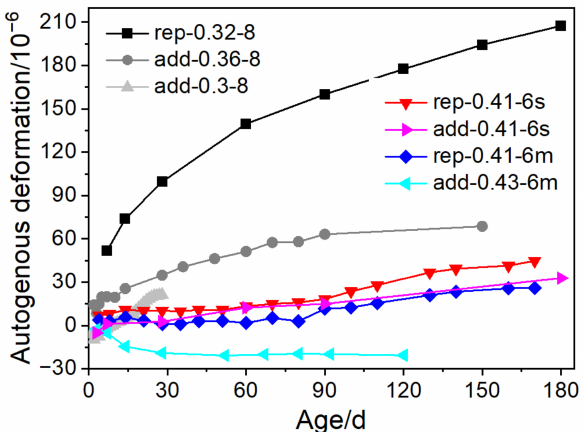
Figure 5. The difference between expansion of concrete with MgO added as replacements (rep) and as additives (add): rep-0.32-8, add-0.36-8, add-0.3-8, rep-0.41-6s, and rep-0.41-6m, add-0.41-6s, and add-0.43-6m (adapted from Ref. [20], 2016, Elsevier; Ref. [28], 2016, Journal of China Institute of Water Resources and Hydropower Research ; Ref. [35], 2009, Journal of Wuhan University of Technology ; Ref. [36], 2009, Springer Nature; Ref. [37], 2018, Hu Y.; and Ref. [38], 2020, Thomas Telford